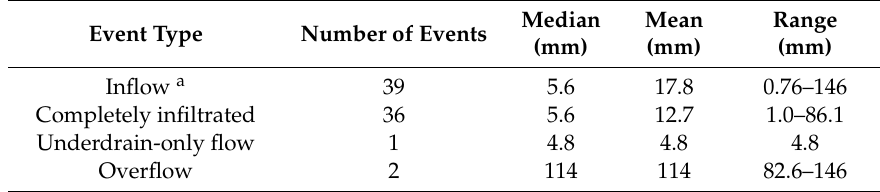
Table 3. Fate of inflow based on HOBO